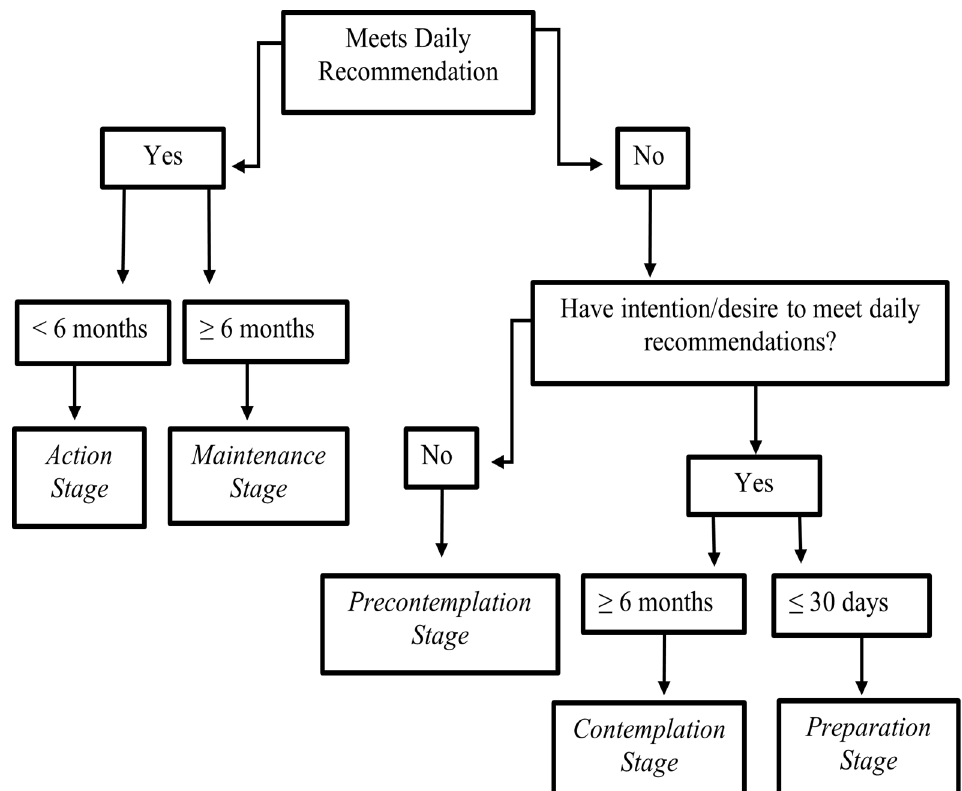
Figure 2. Stage of Change Assessment Flowchart.